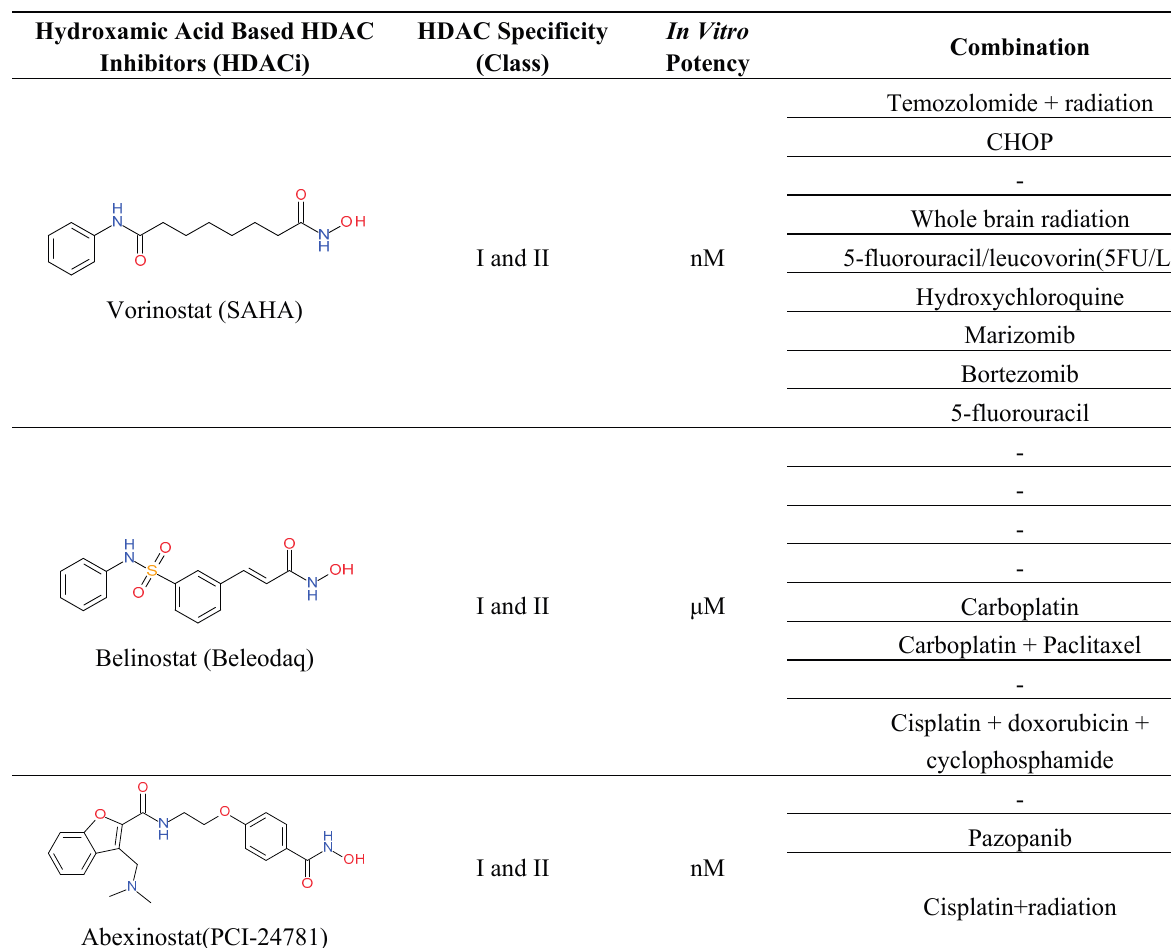
Table 2. Hydroxamic acid based HDAC inhibitors in clinical